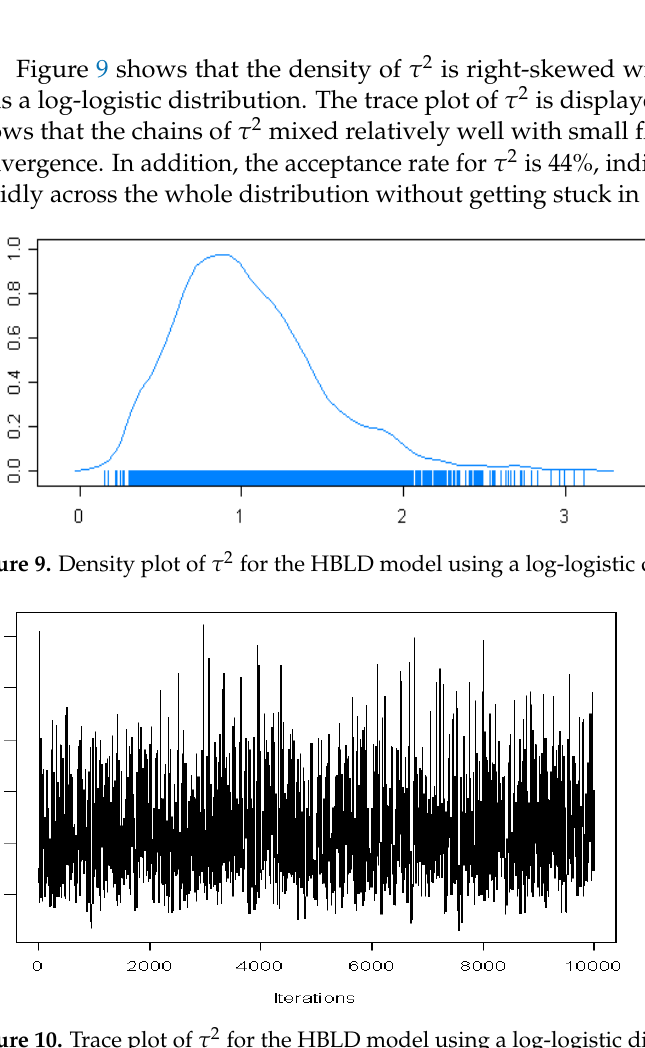
Figure 10. Trace plot of τ 2 for the HBLD model using a log-logistic distribution.